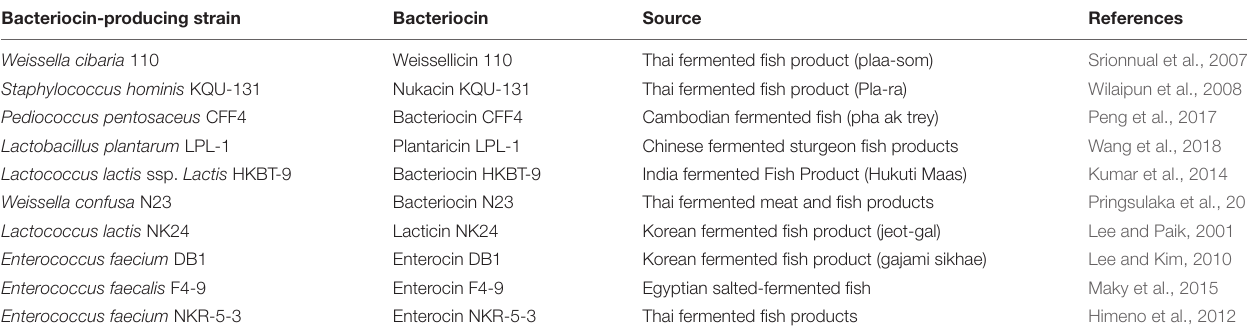
FIGURE 5 | Effects of temperature (A) , pH (B) , surfactants (C) , and protease (D) on the stability of enterocin Gr17. TABLE 5 | The bacteriocin-producing strains from fermented fish of different